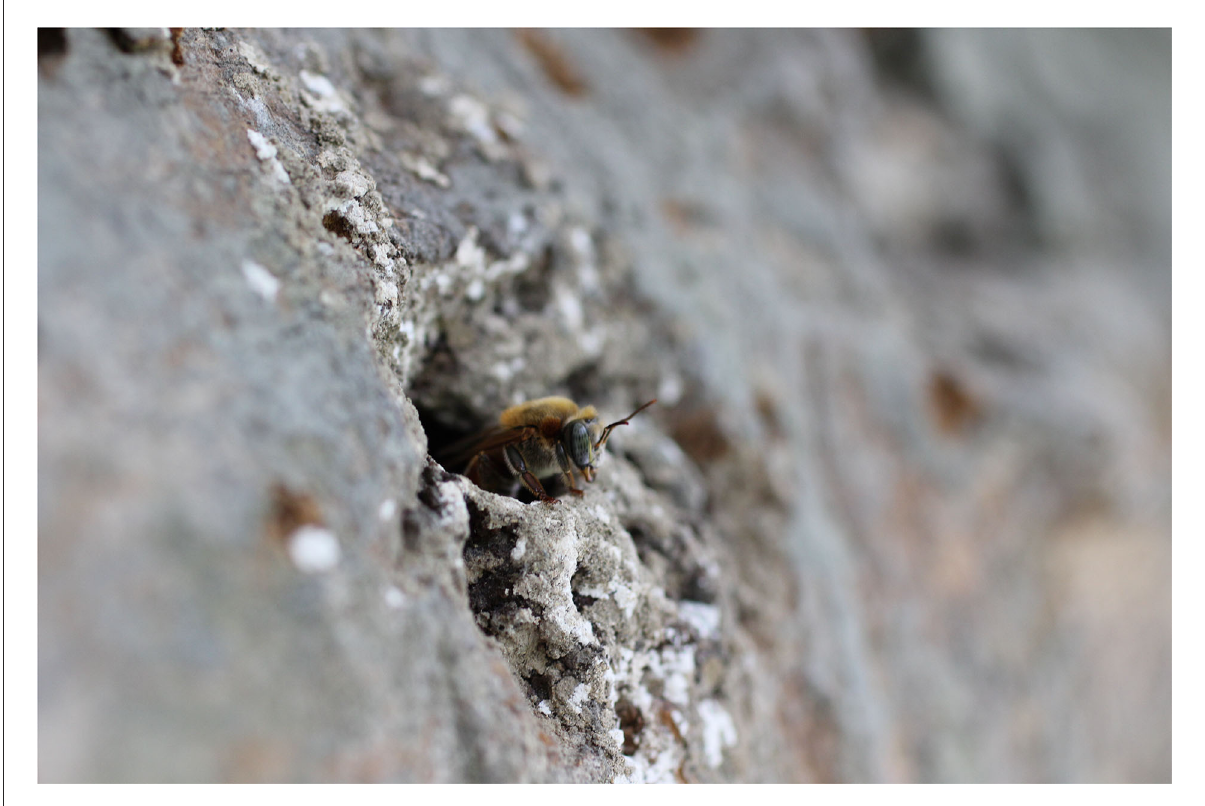
FIGURE1 Mosca real o abeja real (in local Spanish; Melipona beecheii